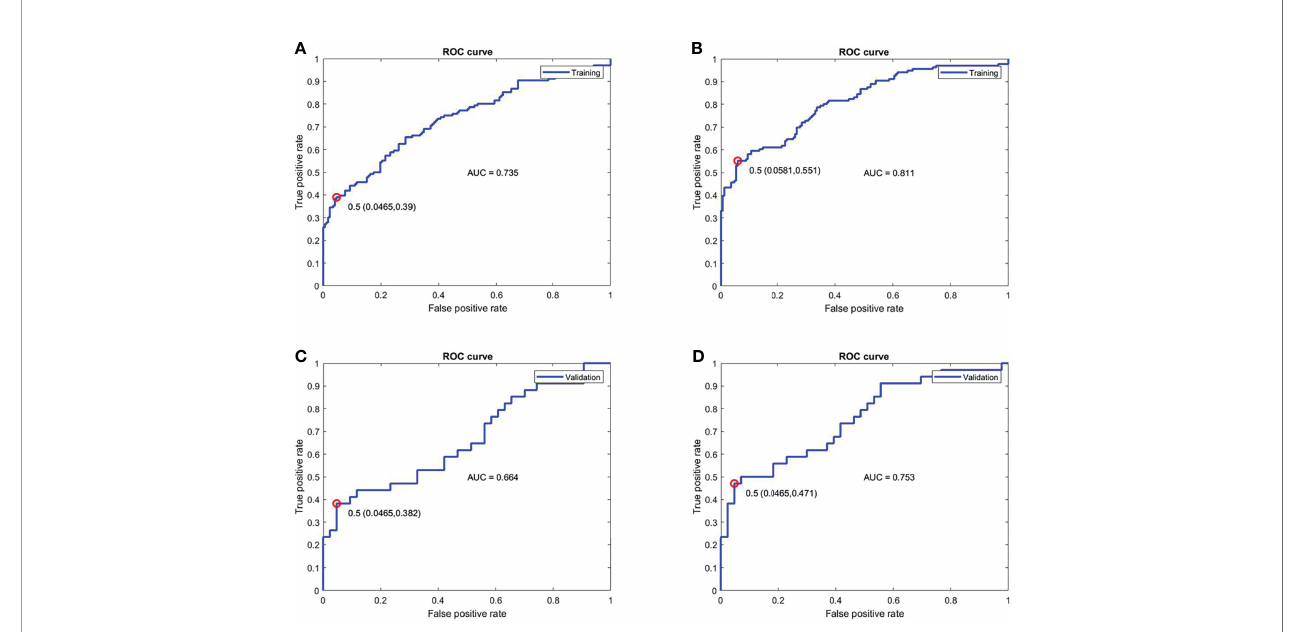
FIGURE 4 | ROC analysis for the performance of the two models for treatment response prediction on the training and validation cohorts. (A, C) The model combining disease duration, ESR, hip effusion and BME in acetabulum showed AUC values of 0.735 and 0.664 for training and validation cohorts, respectively. (B, D) The model integrated disease duration, CRP, ESR, hip effusion and BME in the acetabulum and femoral head obtained better predictive ability with AUC values of 0.811 and 0.753 in the training and validation cohorts, respectively. ROC, Receiver operator characteristic; ESR, erythrocyte sedimentation rate; CRP, C-reactive protein; BME, Bone marrow edema; AUC, Area under the